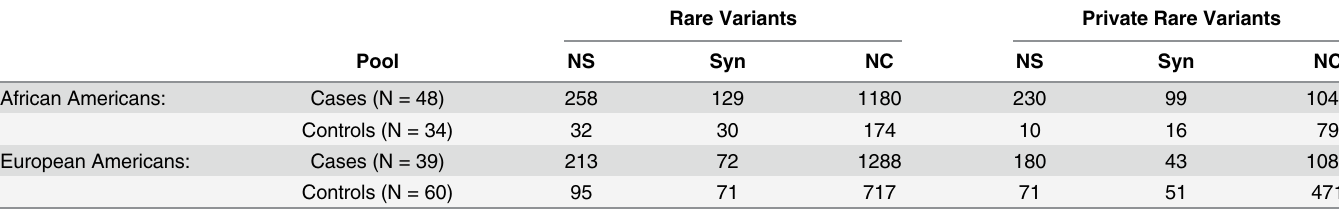
Table 3. Counts of rare and private rare variants in asthma cases vs. controls in anonymous pooled sequencing of coding exons of 131 candidate genes. Private variants are those private to either cases or controls within an ethnicity. NS = nonsynonymous, Syn = synonymous, NC =